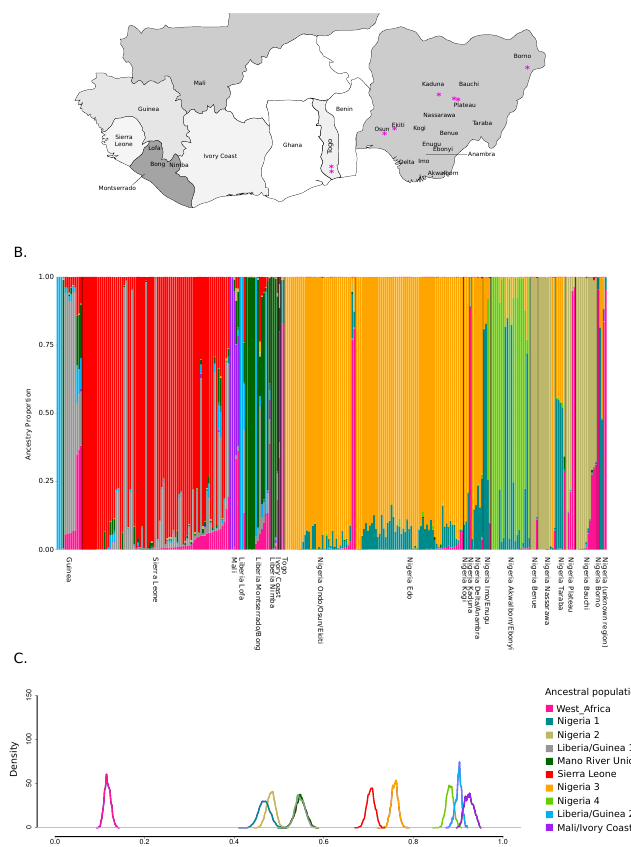
Figure 1. Population structure of Lassa mammarenavirus (LASV) in West Africa. ( A ). Map of the LASV endemic area in West Africa. Countries where LASV genomes were sampled are shaded in di ff erent hues of gray. In Nigeria and Liberia, the states / prefectures of origin of LASV sequences are shown. The magenta asterisks denote the origin of sequences having a major ancestry component from ancestral population West_Africa. ( B ). Bar plot representing the proportion of ancestral population components from the STRUCTURE linkage model for K = 10. Each vertical line represents a LASV genome. Genomes are ordered by country and by following a roughly west-to-east gradient. ( C ). Distributions of posterior F values for the ancestral populations. Colors are as in panel